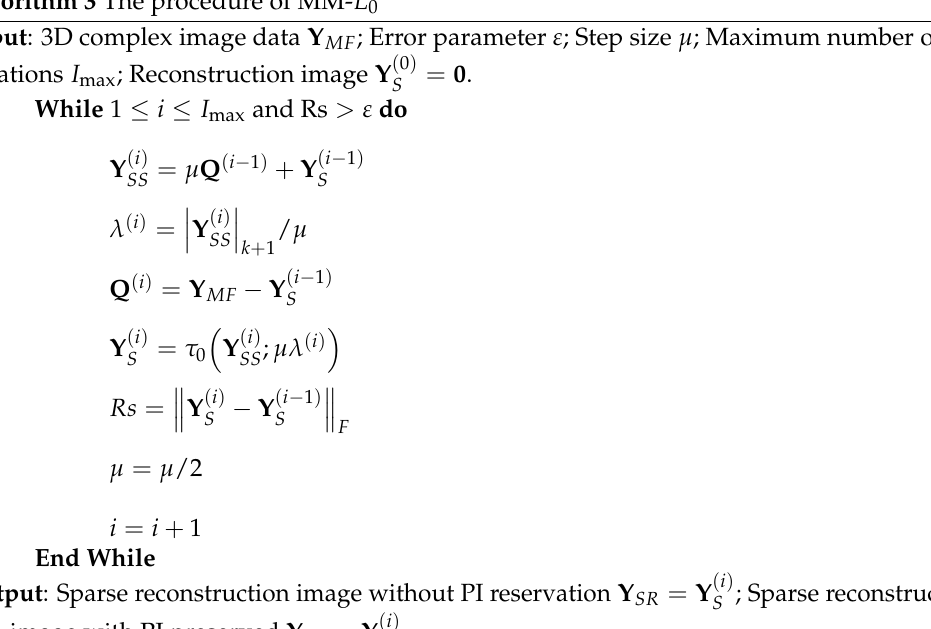
Algorithm 3 The procedure of MM- L